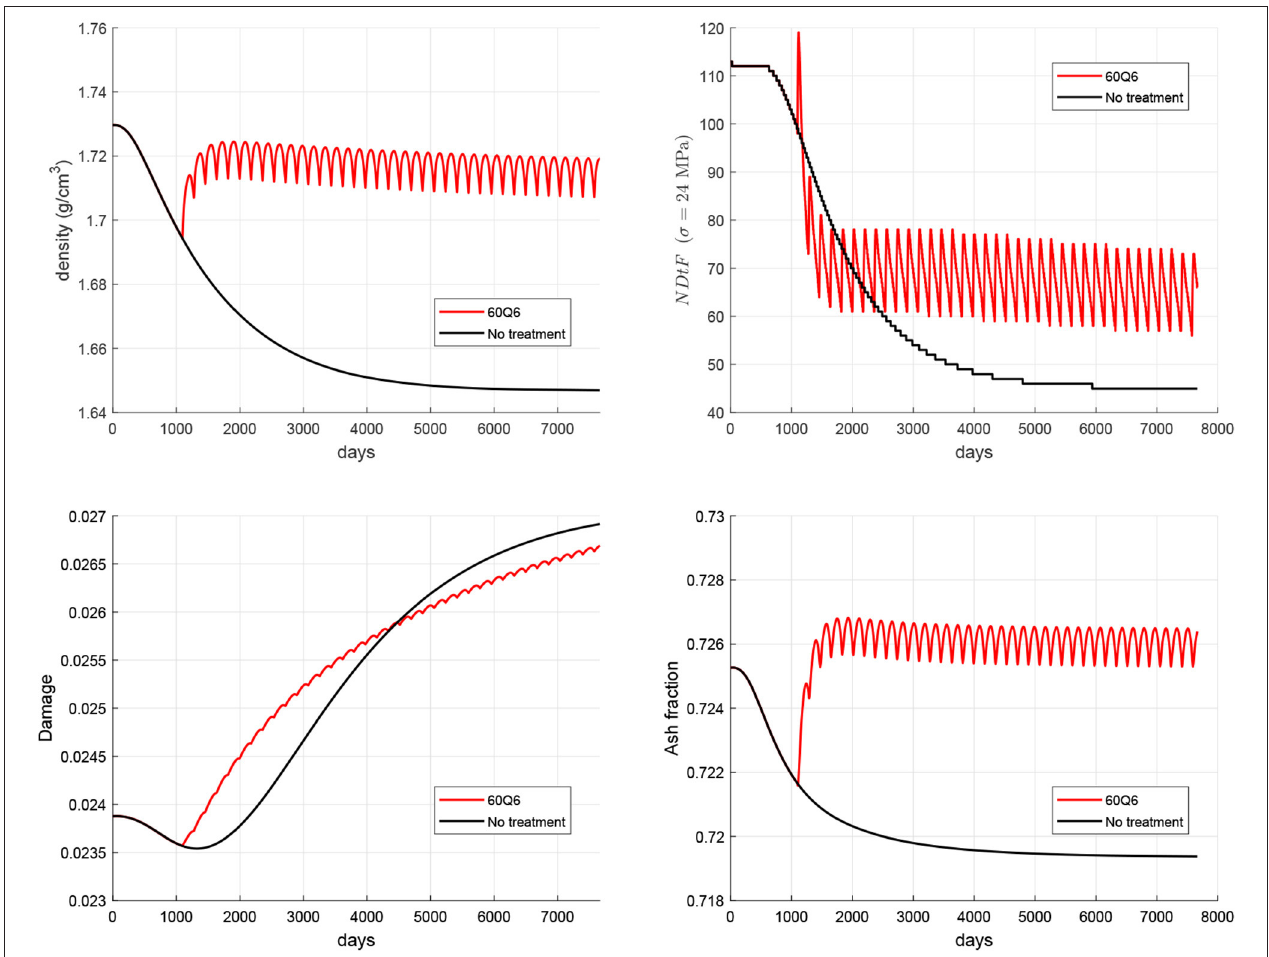
FIGURE 5 | Evolution of density (top left), damage (bottom left), mineral content (bottom right), and NDtF corresponding to an overload σ = 24 MPa (top right) for the WHO-approved treatment 60Q6 and comparison with the non-treatment